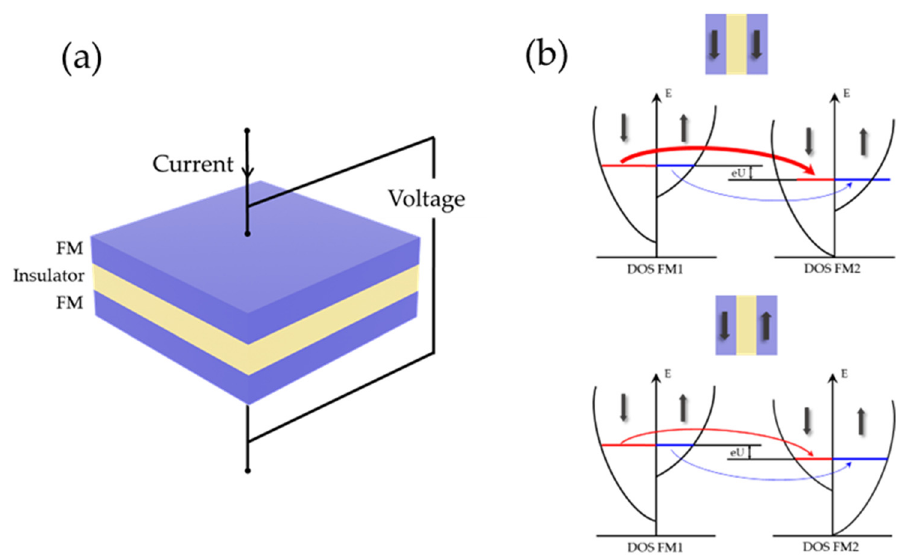
Figure 5. ( a ) Schematic representation of the GMR element, where current is flowing parallel to the film. ( b ) Schematic illustration of the two current models of GMR effect, explaining spin-dependent scattering of parallel magnetization and anti-parallel magnetization at the interface between FM and NM metal layers. Black arrows: the magnetization state of the FM layer. Blue arrows: trajectories of spin-up conduction electron. Red arrow: trajectories of spin-down conduction electron.